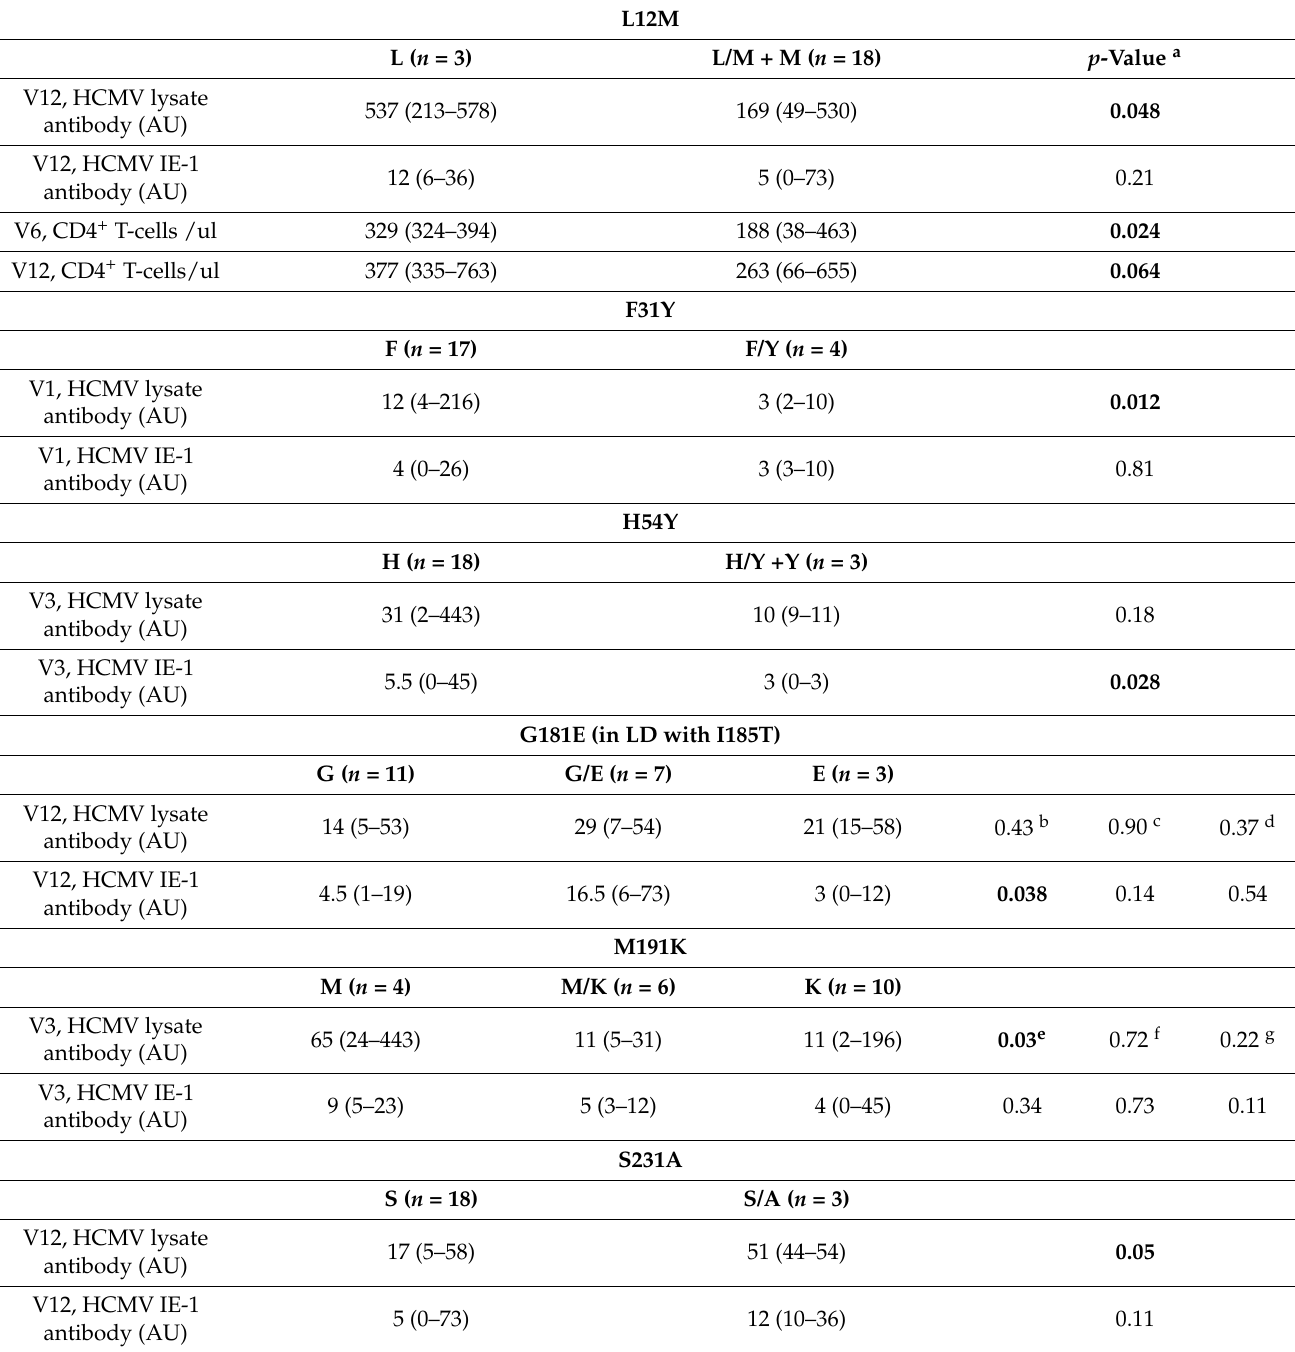
Table 2. UL18 variants are associated with altered HCMV-reactive antibody levels in